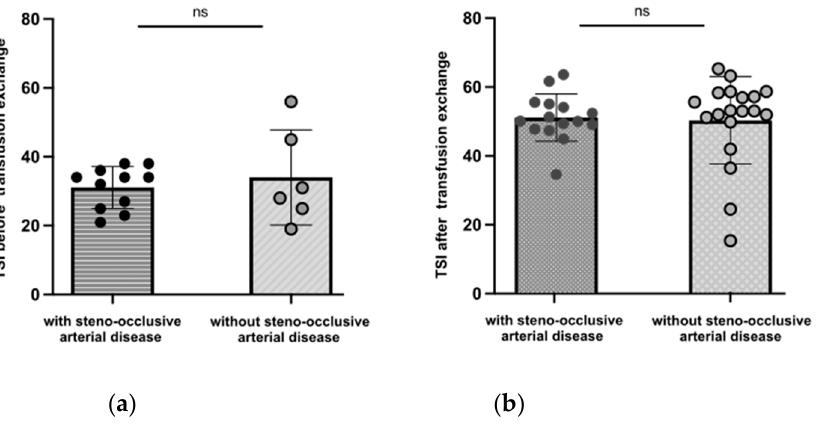
Figure A3. NIRS measurement of TSI (%) in cerebral hemispheres with and without steno-occlusive arterial disease before and after BET. Box whisker plots show range, interquartile percentages for TSI. (a) TSI before transfusion (with steno-occlusive arterial disease, n = 15 and without steno-occlusive arterial disease, n = 19). (b) TSI after transfusion (with steno-occlusive arterial disease, n = 15 and without steno-occlusive arterial disease, n = 19). ns using the Mann–Whitney test.